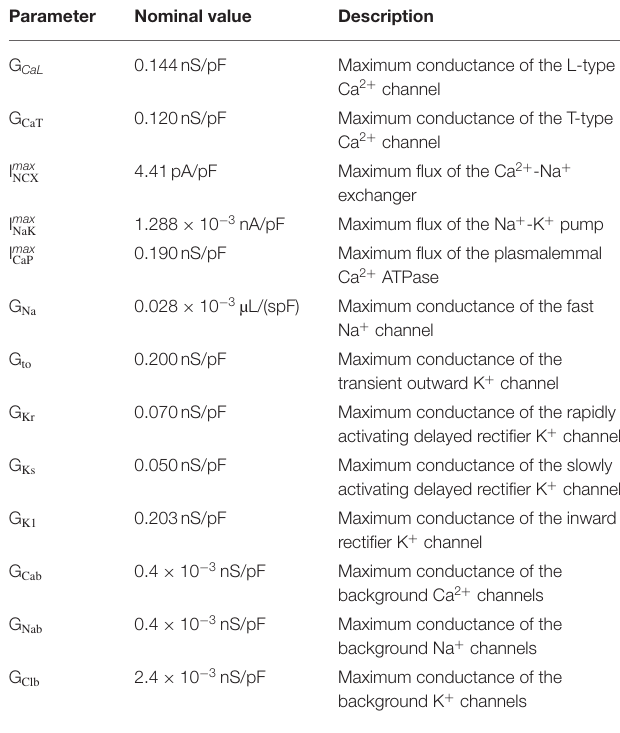
TABLE 1 | List of the maximum conductances of the ionic currents in the model and their nominal